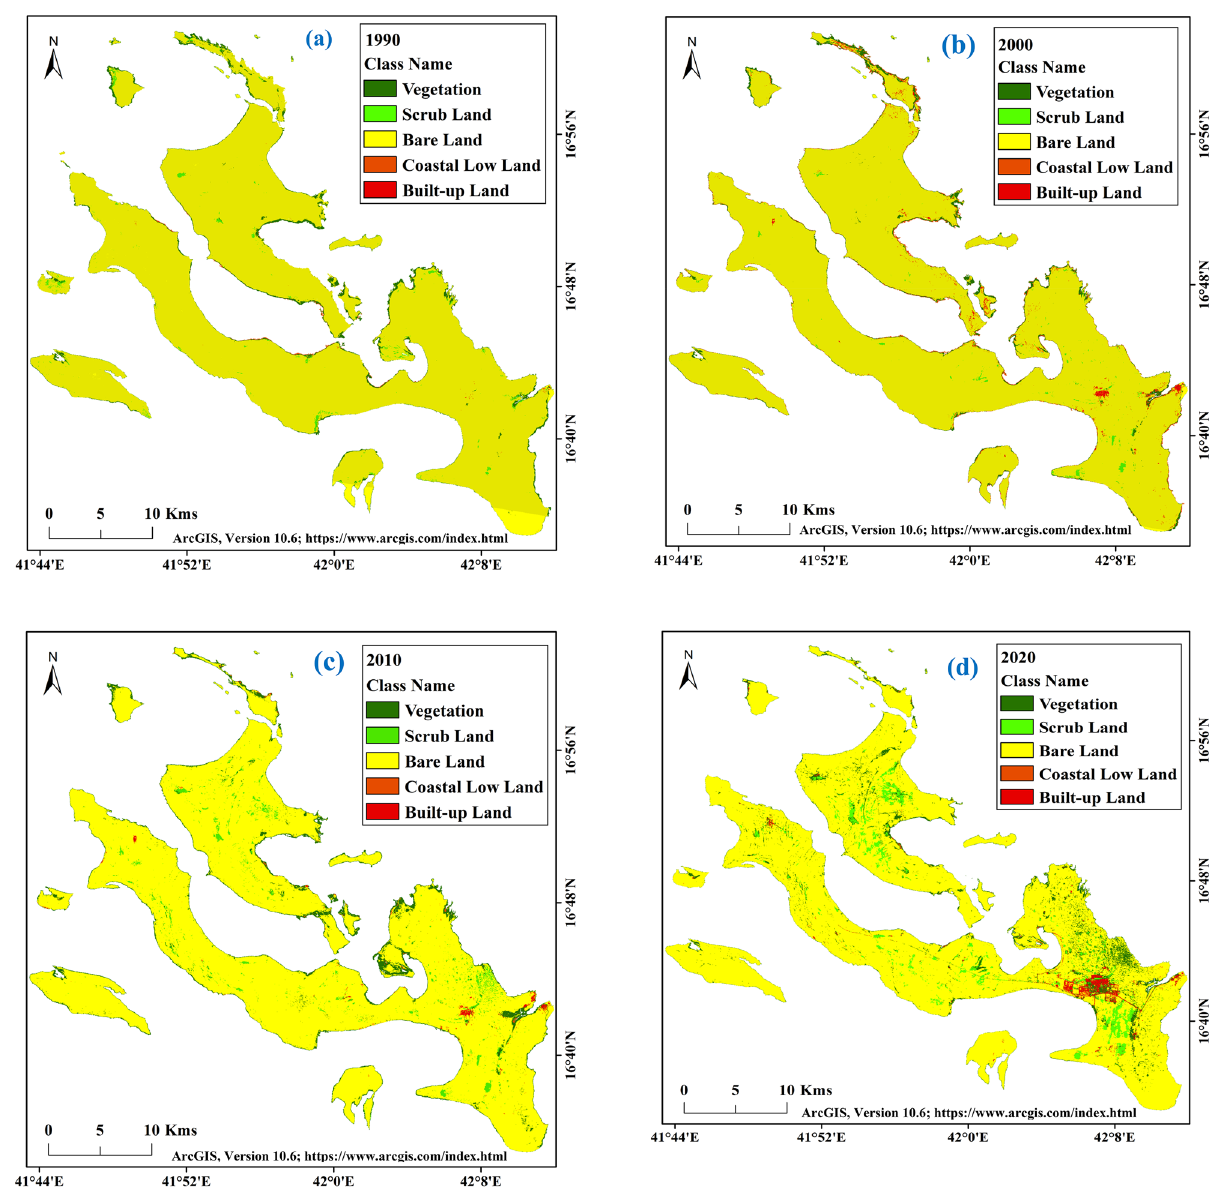
Figure 3. Land use and land cover classification maps of Farasan Islands; ( a ) 1990; ( b ) 2000; ( c ) 2010; ( d ) 2020 31,64 . The satellite datasets were downloaded from USGS earth explorer (https:// earth explo rer. usgs. gov/). The map was generated using ArcGIS software, version 10.6 (https:// suppo rt. esri. com/ zh- cn/ produ cts/ deskt op/ arcgis- deskt op/ arcmap/ 10-6-1).